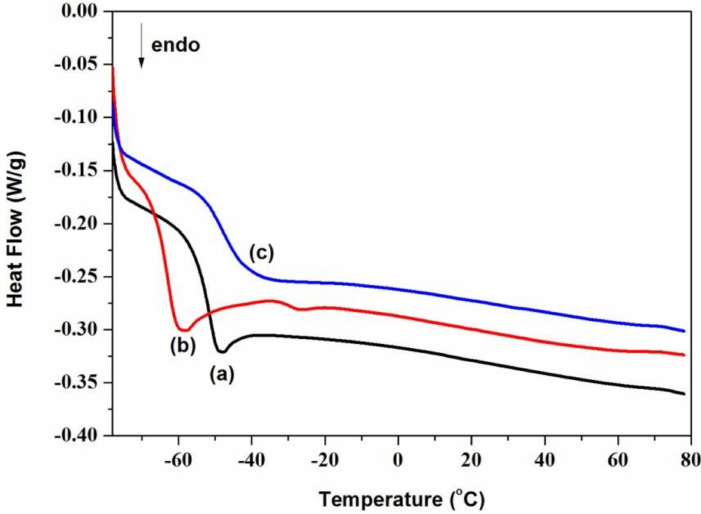
Figure 4. DSC curves of oils: ( a ) castor oil, ( b ) CCO and ( c )